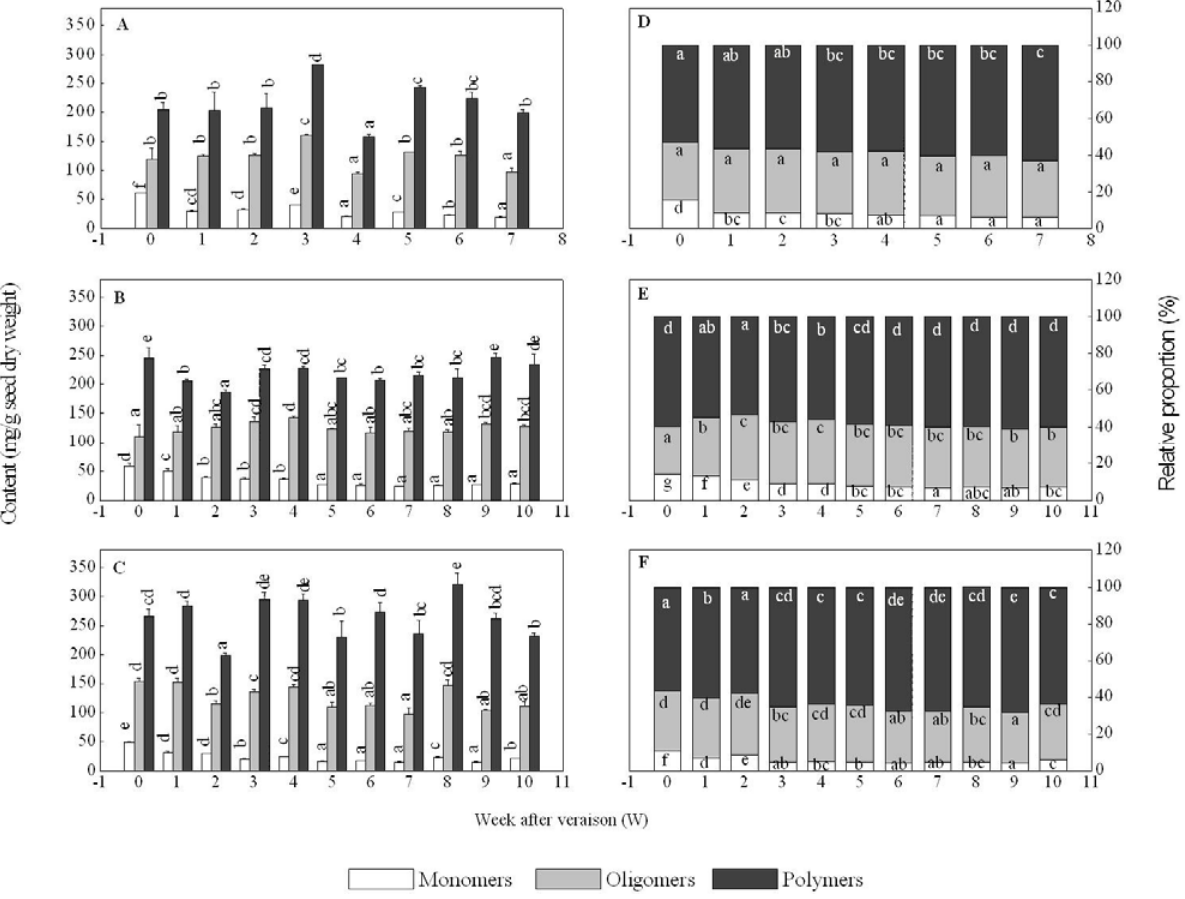
Figure 4. The content and relative proportions of monomers, oligomers and polymers in ‘Shiraz’ (A, D), ‘Cabernet Sauvignon’ (B, E) and ‘Marselan’ (C, F) grape seeds after